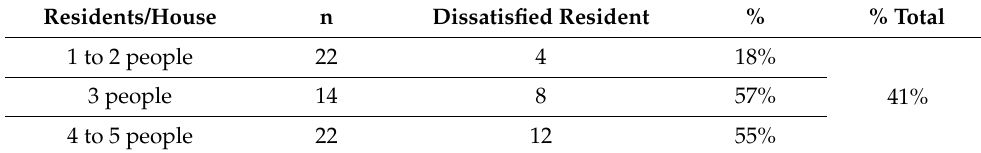
Table 3. Residents’ dissatisfaction with bathroom size, by number of residents.